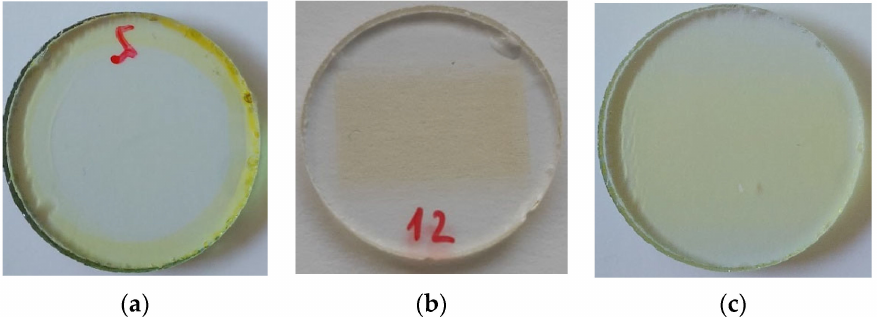
Figure 2. Optical sensor layers produced on glass substrates using three different techniques: ( a ) spin coating (SC), ( b ) inkjet printing (IC), and ( c ) spray coating